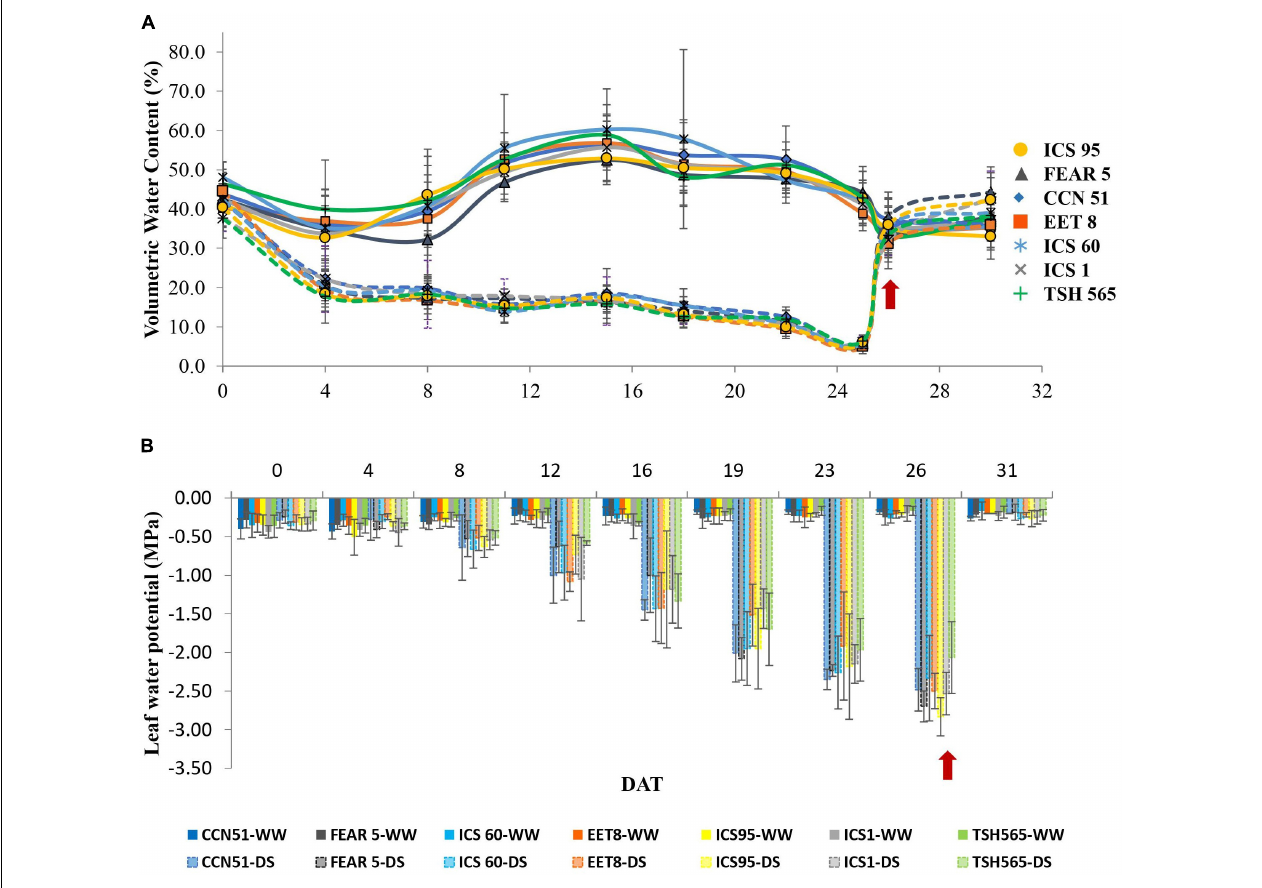
FIGURE 1 | Variation in the (A) soil volumetric water content and (B) predawn water potential of cacao clones under different water states. WW, well-watered (solid lines); DS, water deficit (dashed lines) conditions. Values are the mean ± SD ( n = 6). The arrows indicate the exact day of rewatering after 26 days of DS.